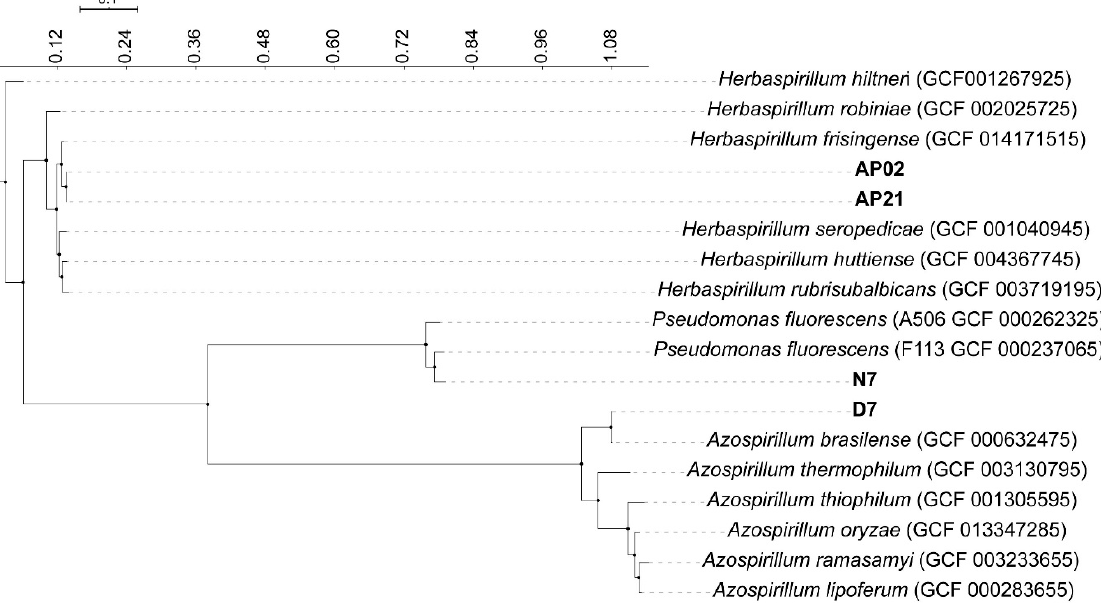
Figure 1. Phylogenetic relationships among the four strains (AP02, AP21, D7, and N7) used in this study and 14 reference strains available in NCBI. To compute this phylogeny, the workflow mentioned by Yeoman et al. (31) was used. Bar: tree scale. Table 1. Representative genes selected to explore the potential growth-promoting traits of the bacteria. AP02: Herbaspirillum sp.; AP21: Herbaspirillum sp.; D7: Azospirillum brasilense .; N7: Pseudomonas fluorescens . PGP, plant growth-promoting;